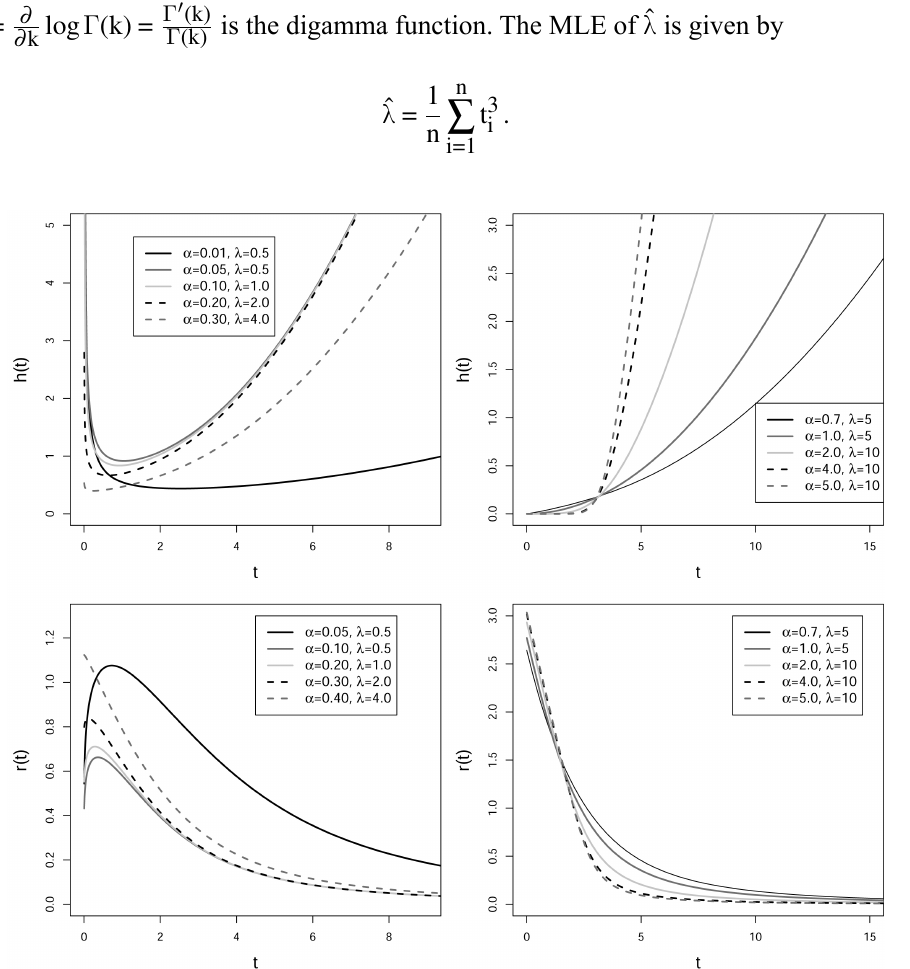
Figure 1 - Hazard and mean residual life function shapes for WH distribution considering different values of α and λ